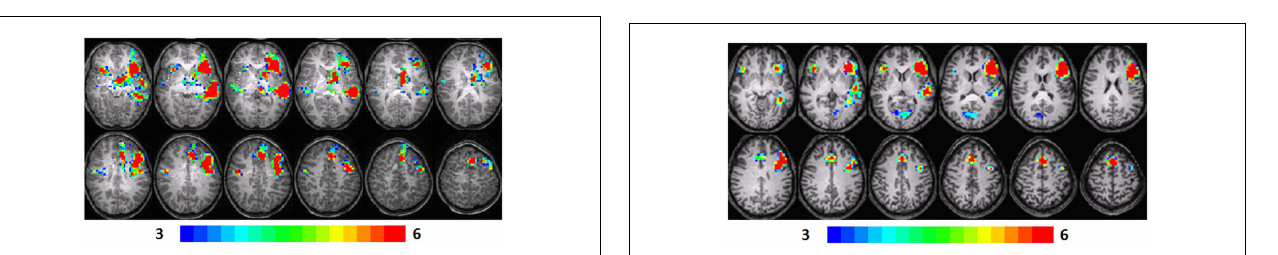
FIGURE 3 | Composite fMRI activation maps for the verb generation (verb generation > finger tapping) inT3 children ( N = 15). The contrast is significant at p < 0.001 (corrected), slice thickness is 5mm for these contiguous slices. Slices range from z = 13 to 24 in theTalairach frame. Cluster size is 30 voxels. Higher significance is indicated in hotter color ( t threshold ranged from 3 to 6). Figure is presented in a radiological orientation (L = R, R =